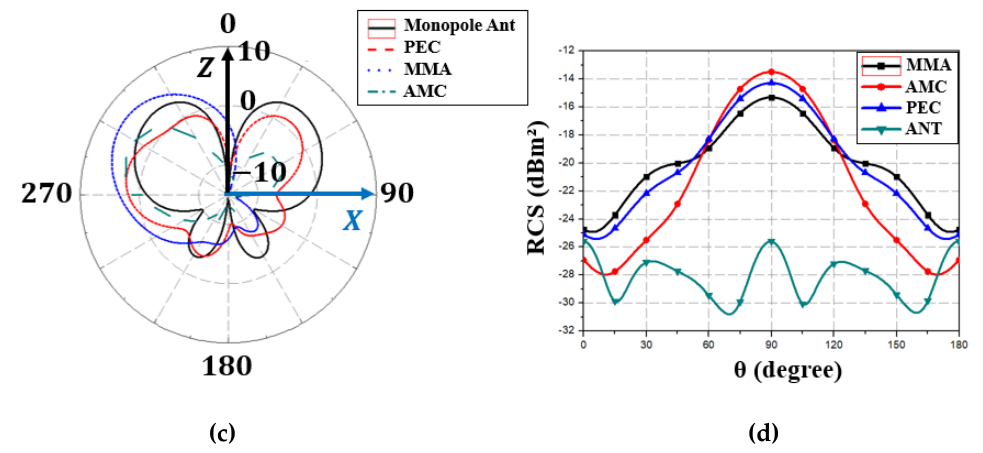
Figure 9. ( a ) Monopole antenna and reflection radiation patterns from perfect electric conductor (PEC), artificial magnetic conductor (AMC), and MM absorbers. ( b ) Simulation setup for RCS analysis in the Computer Simulation Technology (CST) Microwave. ( c ) Simulated two-dimensional radiation patterns for the proposed and reference antennas at 2.65 GHz. ( d ) Simulated radar cross-section (RCS) for the proposed and reference 1, 2, and 3 antennas at 2.65 GHz. Table 2. Simulation performance metrics for proposed and reference antennas.